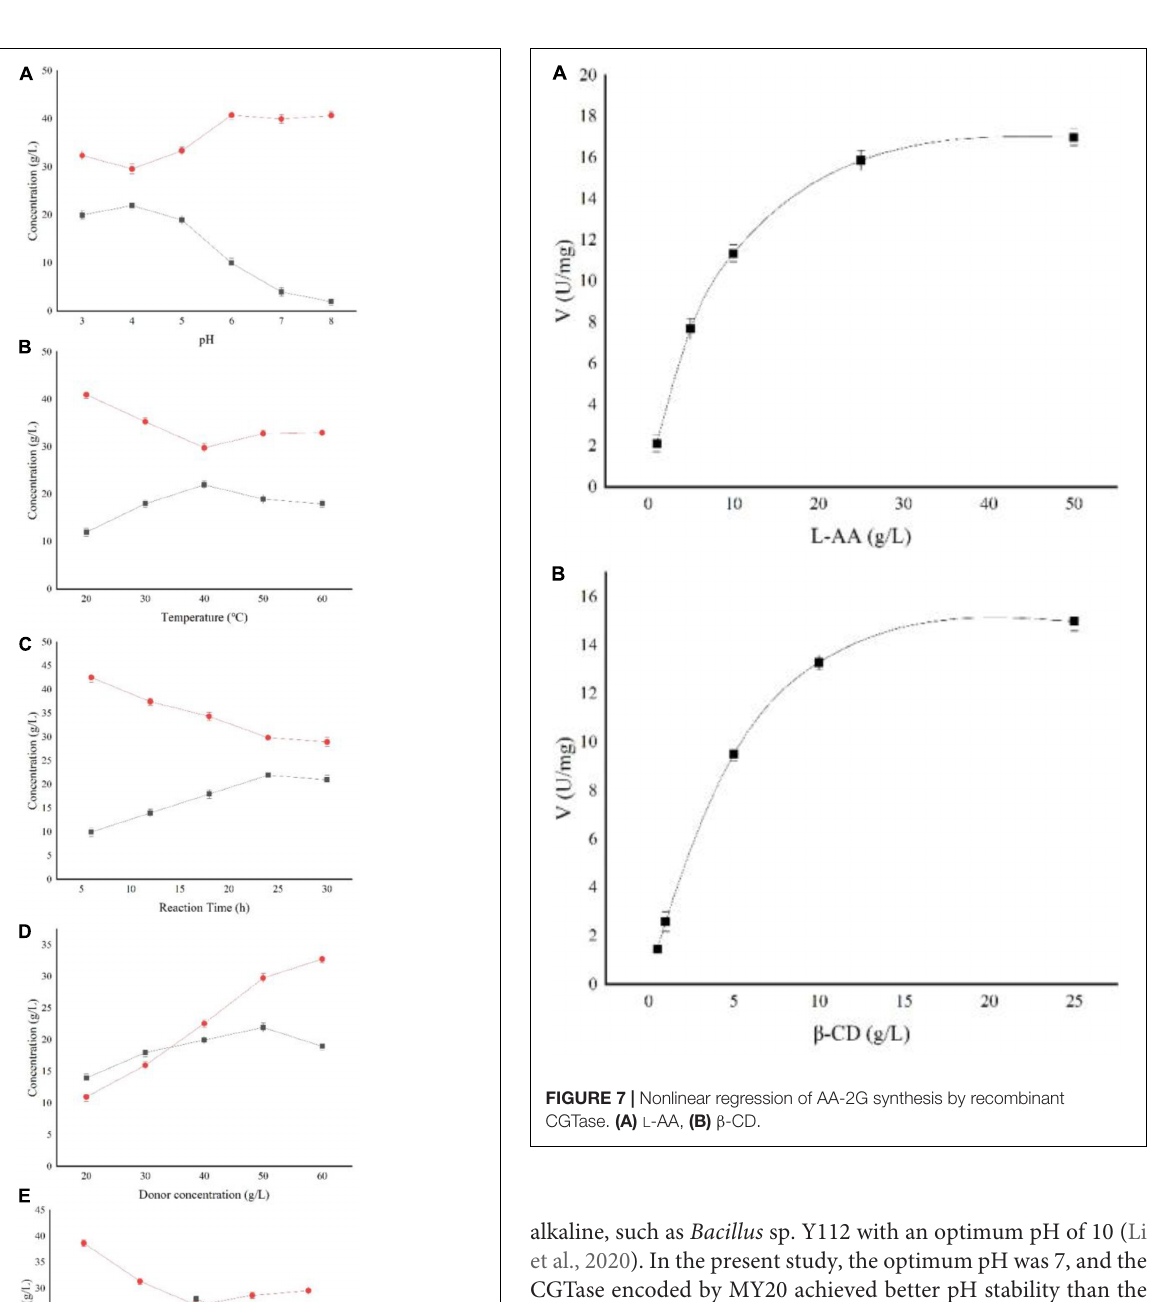
alkaline, such as Bacillus sp. Y112 with an optimum pH of 10